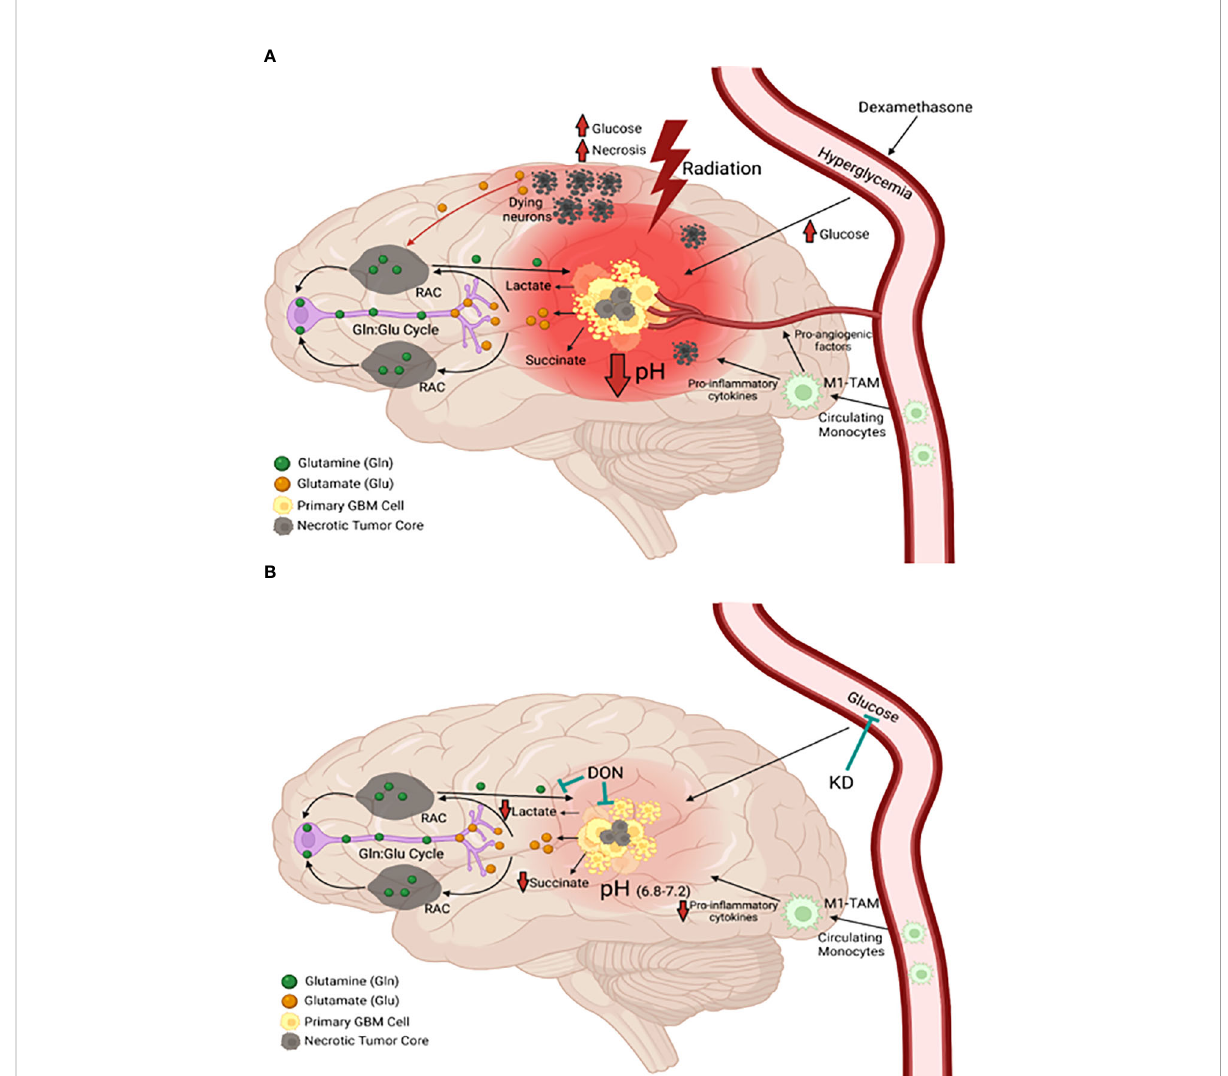
FIGURE 3 Origin and management of microenvironment acidity in GBM. (A) Glucose and glutamine are the primary energy metabolites necessary for driving rapid GBM growth. Glucose is the metabolic fuel necessary for nearly all brain functions under normal physiological conditions and is the major source of carbons for biomass synthesis through the glycolytic and pentose phosphate pathways in tumor cells. Tumor cells metabolize glutamine to glutamate, which is then metabolized to alpha-ketoglutarate. Signi fi cant energy is generated from the succinyl CoA ligase reaction (substrate level phosphorylation) in the glutaminolysis pathway using alpha-ketoglutarate-derived succinyl CoA as substrate (see Figure 7). In contrast to extracranial tissues, where glutamine is the most available amino acid, glutamine is tightly regulated in the brain through its involvement in the glutamate-glutamine cycle of neurotransmission (1, 78, 79). Glutamate is a major excitatory neurotransmitter that must be cleared rapidly following synaptic release in order to prevent excitotoxic damage to neurons (1, 79 – 81). Glial cells possess transporters for the clearance of extracellular glutamate, which is then metabolized to glutamine for delivery back to neurons. Neurons metabolize the glutamine to glutamate, which is then repackaged into synaptic vesicles for synaptic release (1). This cycle maintains low extracellular levels of both glutamate and glutamine in the normal neural parenchyma. Disruption of the cycle can provide neoplastic GBM cells access to glutamine. Besides serving as a metabolic fuel for the neoplastic tumor cells, glutamine is also an important fuel for cells of myeloid linage, which include macrophages, monocytes, microglia, and especially the invasive mesenchymal cells in GBM (1, 13, 82 – 84). In contrast to the proliferative GBM stem cells, the neoplastic GBM mesenchymal cells are thought to be derived from microglia or from microglia-stem cell fusion hybrids, which would have immuno-suppressive properties (82, 85). As long as GBM cells have access to glucose and glutamine, the tumor will grow and acidify the microenvironment making long-term management dif fi cult. The current treatments for GBM (radiation and TMZ chemotherapy) will further increase glucose and glutamine availability, creating an unnecessary metabolic storm that will enhance microenvironment acidi fi cation and rapid tumor recurrence. The red hue is indicative of the in fl ammation and acidi fi cation of the tumor microenvironment (see text for further details). (B) The simultaneous restriction of glucose and glutamine, while elevating non-fermentable, anti-in fl ammatory ketone bodies, will reduce acidi fi cation, restore the pH balance of the microenvironment, and growth arrest or kill most of the neoplastic cells (11 – 13). RAC, reactive astrocytes; TAM, tumor-associated macrophages; Gln, glutamine; Glu, glutamate. These images were modi fi ed from that in